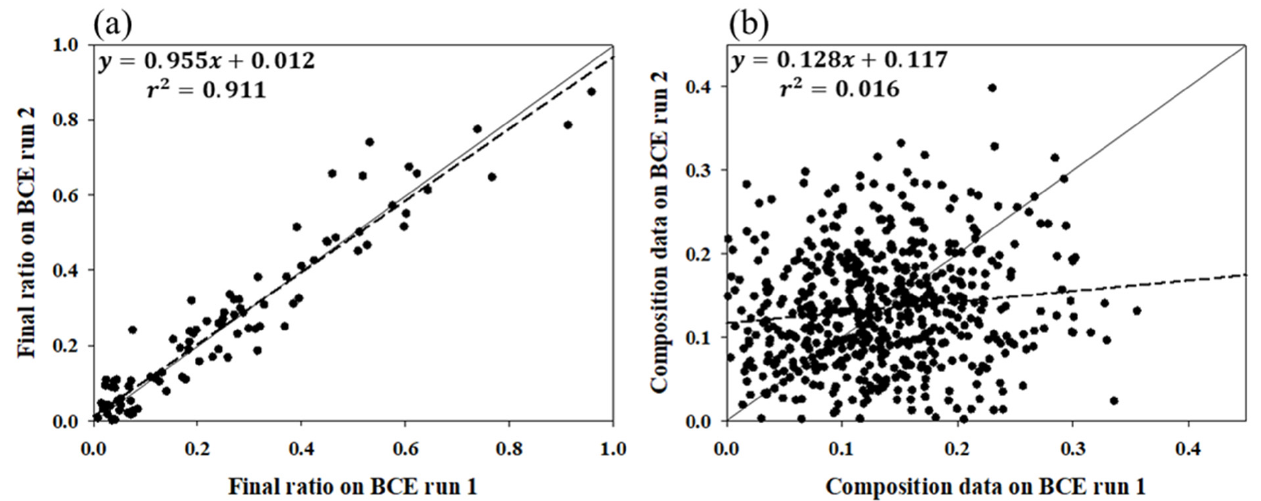
Figure 5. Comparison of the results of two BCE runs. ( a ) Comparison of final ratios between BCE runs 1 and 2, and ( b ) composition data for BCE runs 1 and 2. Dashed and solid lines are regression and 1:1 lines, respectively.